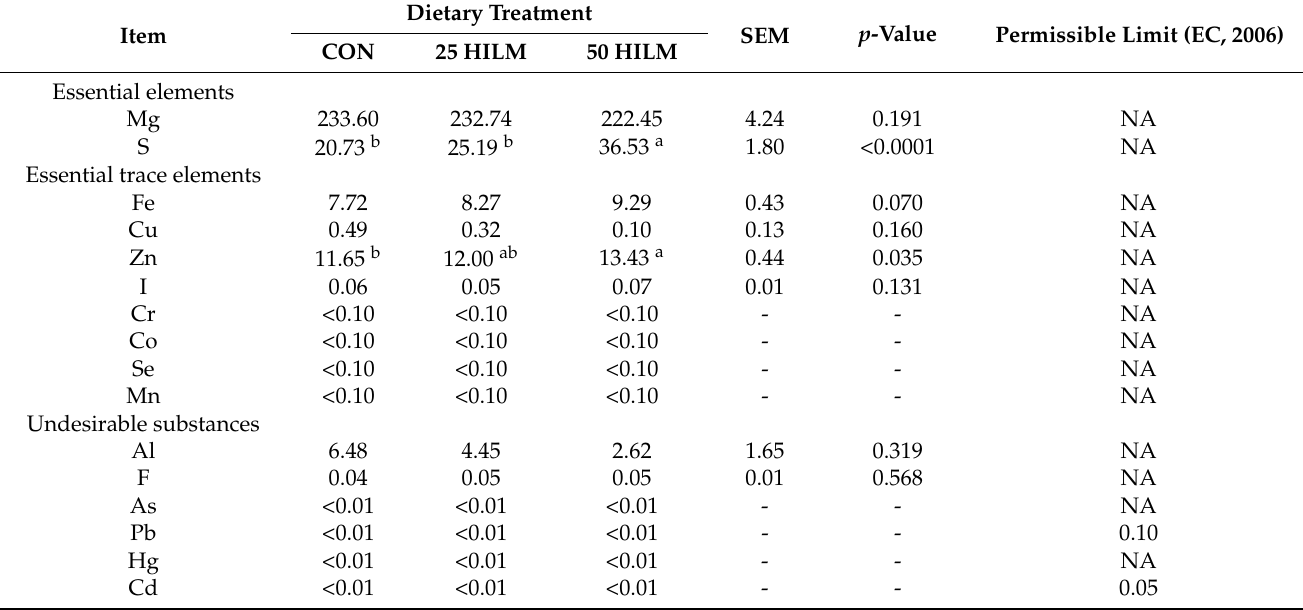
Table 8. Essential elements and undesirable substances (mg/kg) in leg meat of broiler chickens fed Hermetia illucens larvae meal